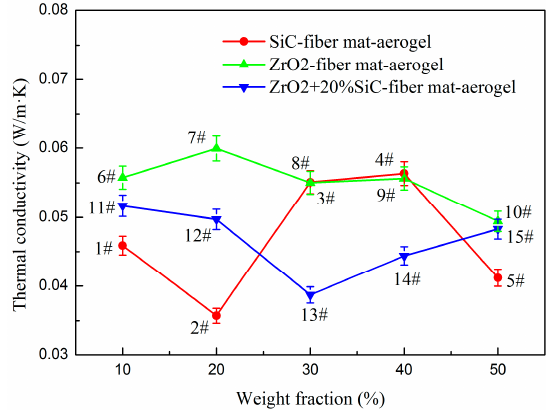
Figure 2. Thermal conductivity comparison with different opacifier content at 25 °C .